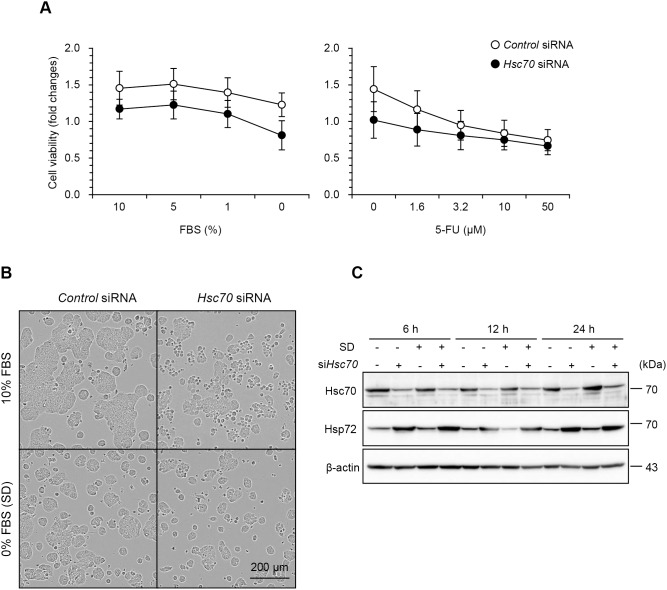
Hsc70 is critical for cancer cell survival.(A) Knockdown of Hsc70 decreased cancer cell viability. HT29 cells were transfected with siRNA for Hsc70 or scramble control. At 48 h after transfection of siRNA, cells were subjected to serum starvation or were treated with 5-FU at the indicated concentration for 48 h. Cell viability was determined by MTS assay. Data points represent the mean ± S.D. (n = 5). (B) Effect of Hsc70 knockdown on cellular morphology. Hsc70 or control knockdown cells were treated the same as in A. Phase-contrast images of cells under serum-fed or serum-free conditions 24 h after treatments. Scale bar, 200 µm. (C) Hsc70 knockdown induced compensatory expression of Hsp72. At 48 h after transfection of siRNA, Hsc70 knockdown or control cells were subjected to serum depletion for 6, 12, or 24 h. After cell lysis, Hsc70 and Hsp72 were detected by immunoblotting. SD, serum depletion.